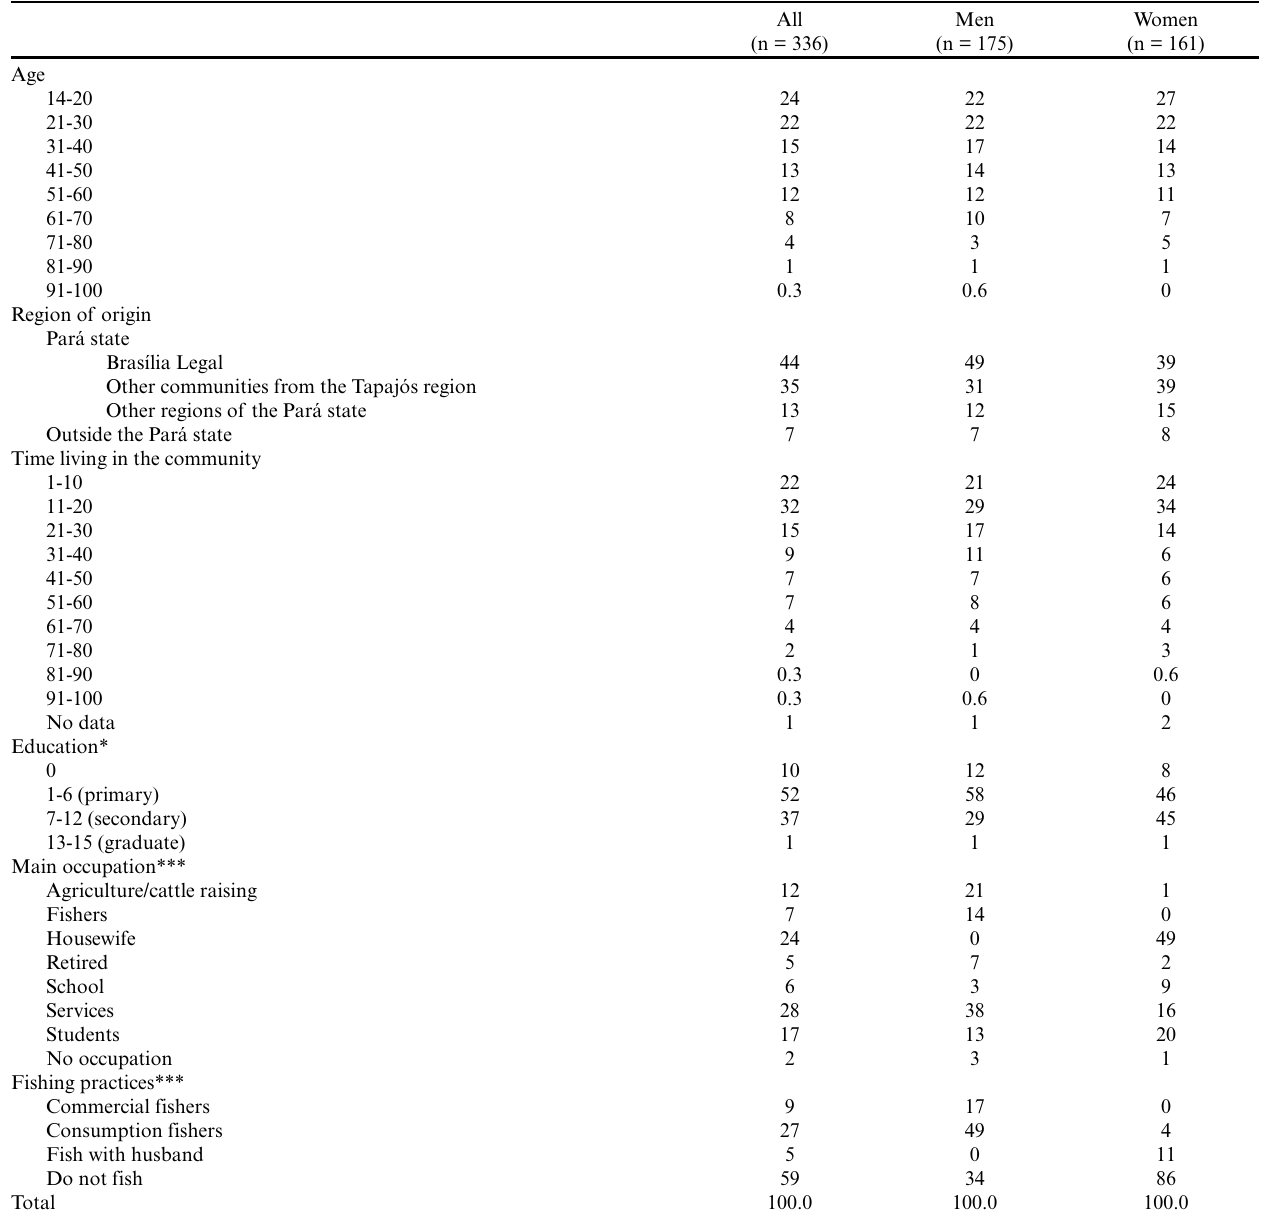
Table 1 . Frequency distributions (%) of socio-demographic characteristics of the participants in the study by gender. χ ² p: *p < 0.05, ** p < 0.01, ***p < 0.001 between men’s and women’s